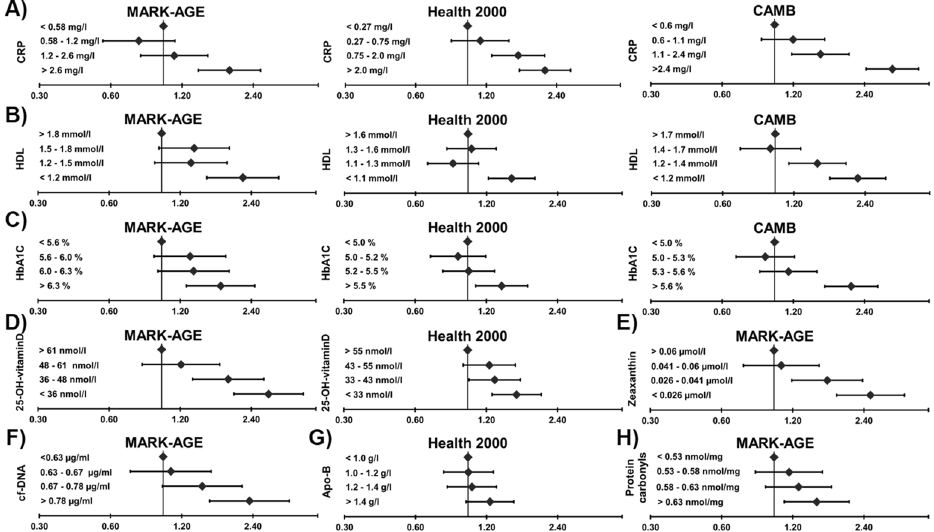
Figure 2. Associations of the eight selected biomarkers, categorized as quartiles, with poor self-rated health. Odds ratios (ORs) and 95% confidence intervals (CIs) are from the logistic regression models, adjusted for age and gender. The “best” biomarker quartile was used as reference category. ( A – H ): C-reactive protein (CRP), high-density lipoprotein (HDL) cholesterol, haemoglobin A1C (HBA1C), 25-hydroxyl-vitamin-D (25-OH-vitaminD), zeaxanthin, apolipoprotein-B (Apo-B), cell-free DNA (cf-DNA) and protein carbonyls, respectively. The biomarkers were selected as examples of replicated and new associations representing different biological domains.